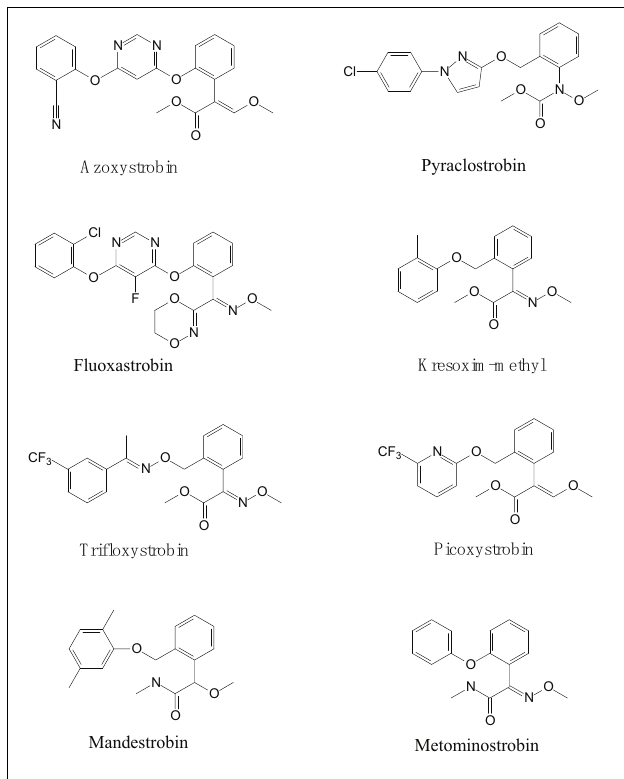
FIGURE 1 | Molecular structures of strobilurins.